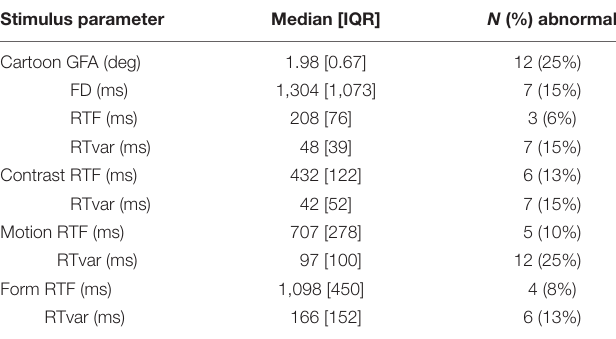
TABLE 4 | Stimulus-specific VOF parameter values and the concurrent N and % of abnormal results compared to the age-matched normative references, in the total group of preterm children at 1 year CA.